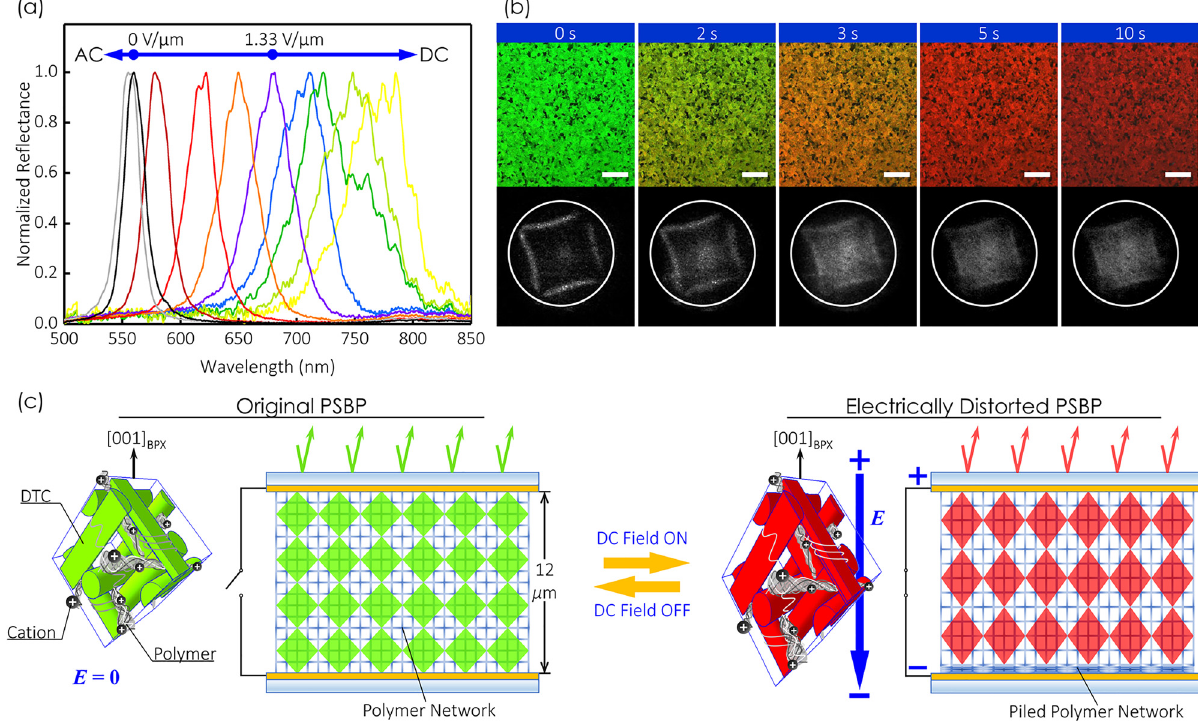
Figure 8: Red-shift of the photonic band-gap. (a) normalized reflection spectra of a 12- μ m thick PSBP film in various DC fields (0 – 2.67 V/ μ m) and an AC fi eld (5.83 V/ μ m). (b) Time-resolved microscopic images (top, scale bars: 100 μ m) and Kössel diagrams (bottom) captured under a DC fi eld of 1.33 V/ μ m. (c) Schematics of the underlying mechanism for the DC-induced band-gap shifting in PSBP. The spectra were normalized to their peak intensities Another example of a polymer-stabilized blue phase wide blue phase (BP) temperature range, including room (PSBP) photonic band-gap (PBG) device with a wide-band temperature, was published by Lin et al. [68]. Such a device spatial tunability in the nearly entire visible region within a was fabricated based on the reverse diffusion of two